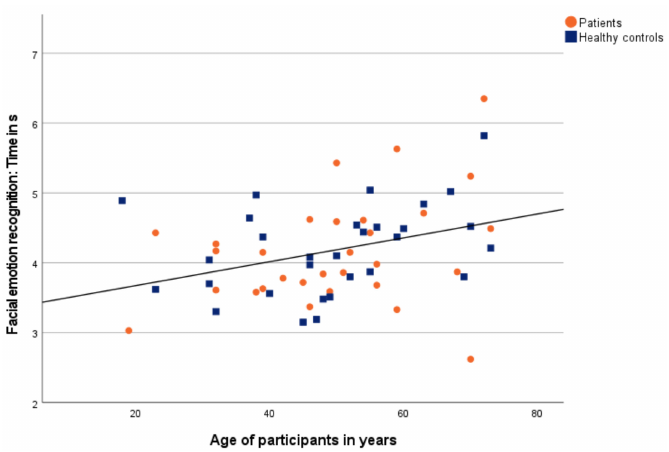
Figure 4. Correlation between time of facial emotion recognition and age. Patients are shown as orange dots, and healthy controls as blue